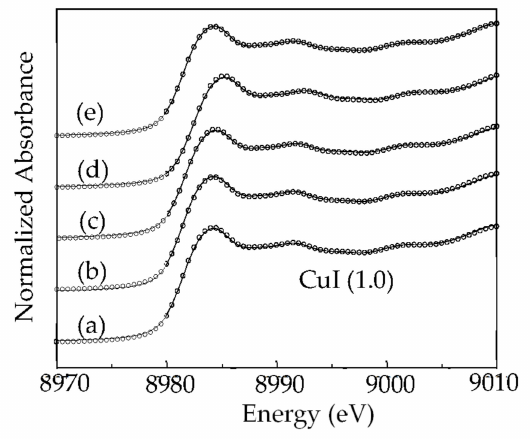
Figure 4. Experimental data (solid line) and the least-squares fit (circles) of XANES spectra of residual copper on the Cu/ITO thin film during extraction with the IL-I at ( a ) 303 ( b ) 343 ( c ) 413 ( d ) 473, and ( e ) 543 K.